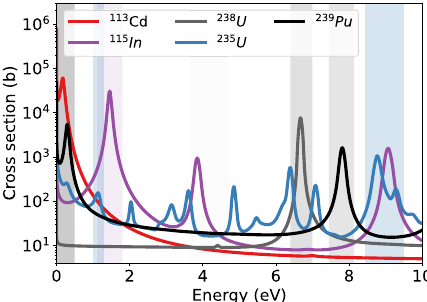
Fig. 7 Distribution of neutron resonances from Table 1. The shades areas indicate the corresponding energy ranges. Cross-sections taken from ref. 2